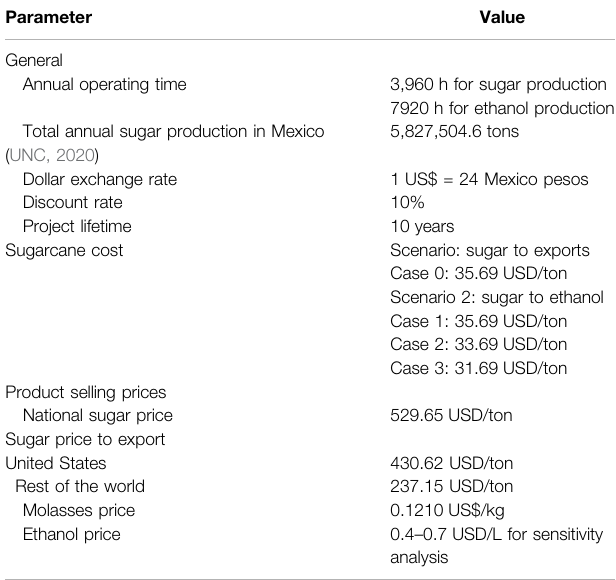
TABLE 3 | Parameters for the techno-economic analysis of the sugar to exports vs. sugar to ethanol. Parameter